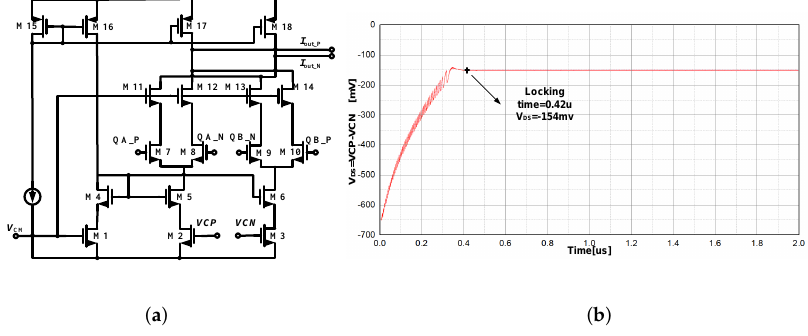
Figure 12. ( a ) Charge pump design, ( b ) The locking process of